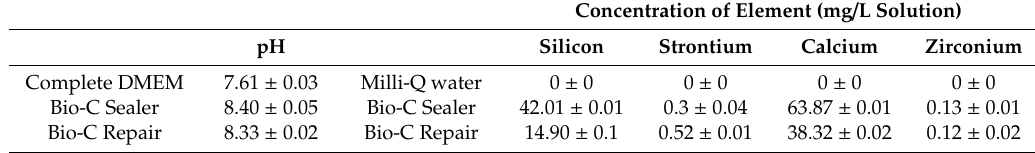
Table 2. Assessment of pH and inductively coupled plasma-mass spectrometry (ICP-MS) of cement